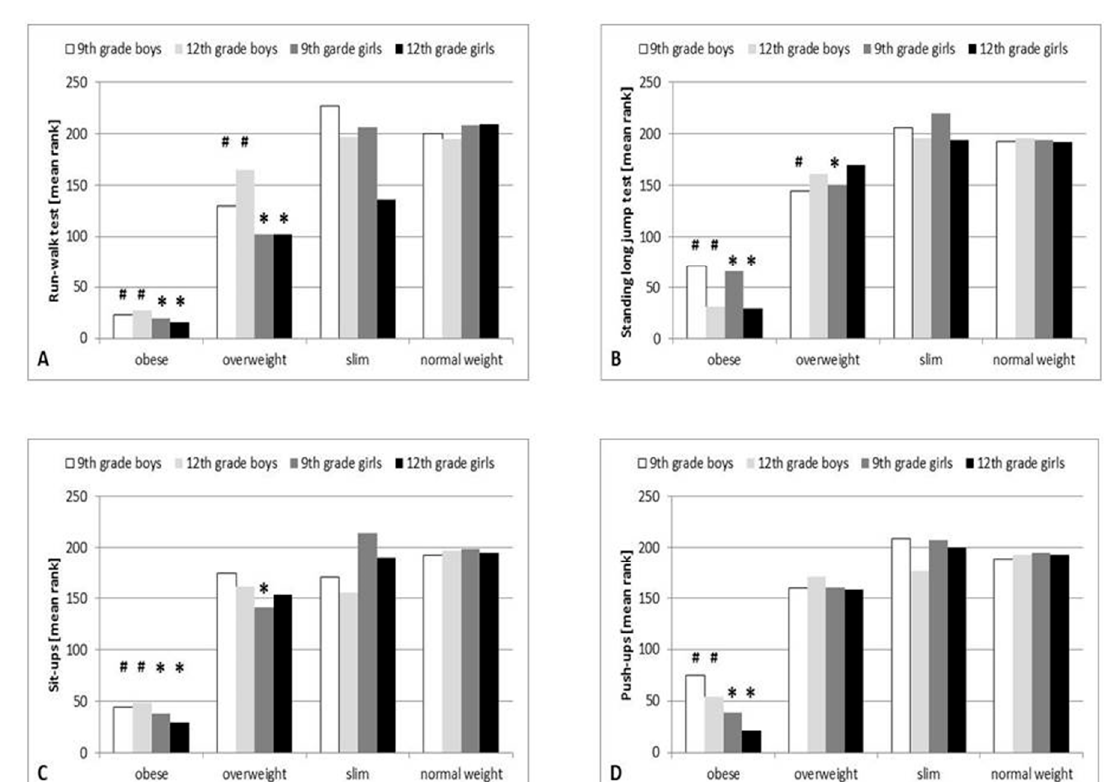
Figure 2. Association between body mass index (BMI)-for-age and aerobic and muscular fitness in adolescents. Run-walk test results are influenced by weight status in both genders (data are shown as mean rank, * = p < 0.05 for obese and overweight girls vs. normal weight girls; # = p < 0.05 for obese and overweight boys vs. normal weight boys) ( A ). Long jump test data were only influenced by obesity among 12th grade students (girls and boys, data are shown as mean rank, * = p < 0.05 for obese girls vs. normal weight girls; # = p < 0.05 for obese boys vs. normal weight boys) ( B ). Sit-up test results were significantly associated with obesity, performance and gender (data are shown as mean rank, * = p < 0.05 for obese girls vs. normal weight girls; # = p < 0.05 for obese boys vs. normal weight boys) ( C ). Push-up test results were significantly influenced by obesity, but not by overweight in both genders (data are shown as mean rank, * = p < 0.05 for obese girls vs. normal weight girls; # = p < 0.05 for obese boys vs. normal weight boys) ( D ).